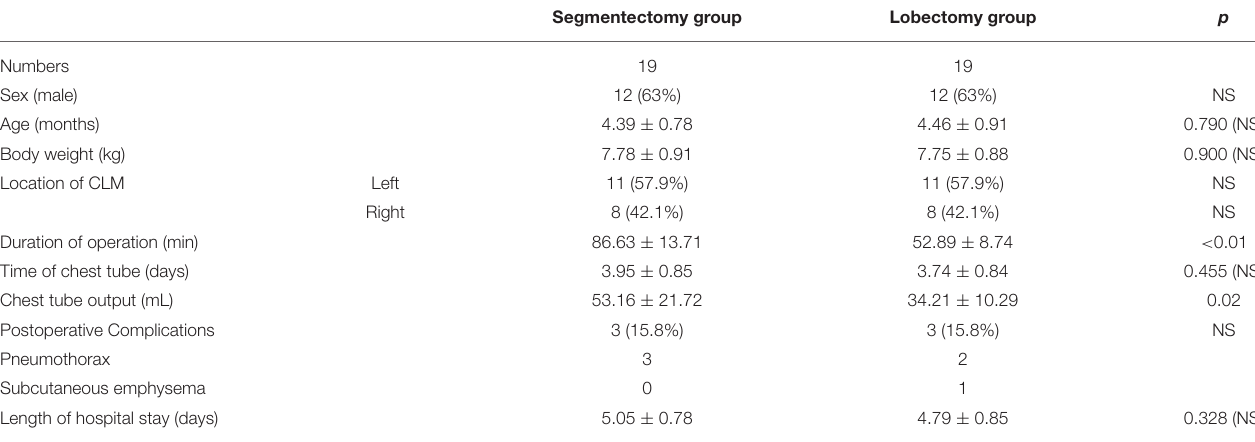
TABLE 1 | Patients’ characteristics and outcomes.